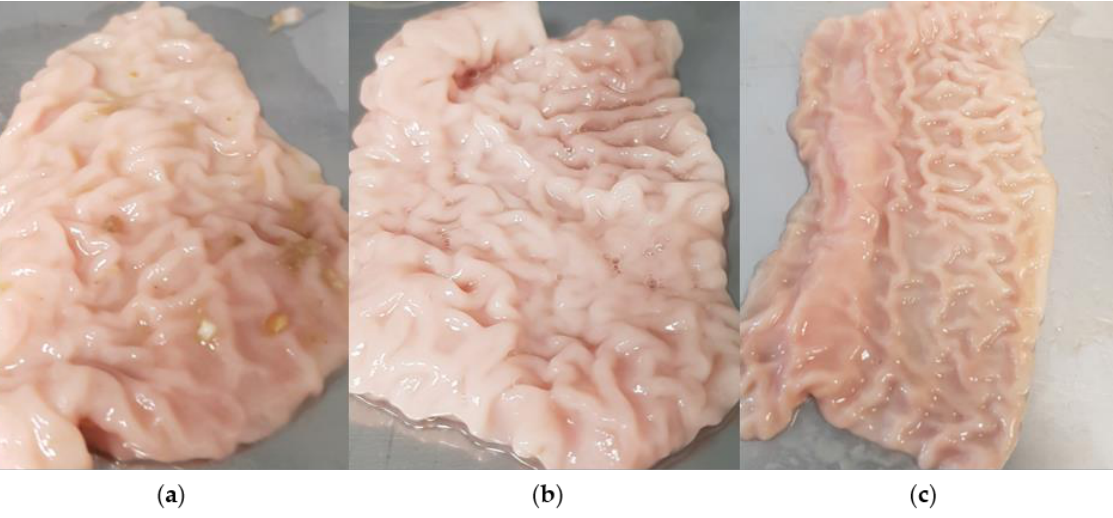
Figure 10. Intraindividual differences between processed tissue samples from pig #1. ( a ) Unprocessed tissue; ( b ) cleaned tissue; ( c ) thawed tissue.